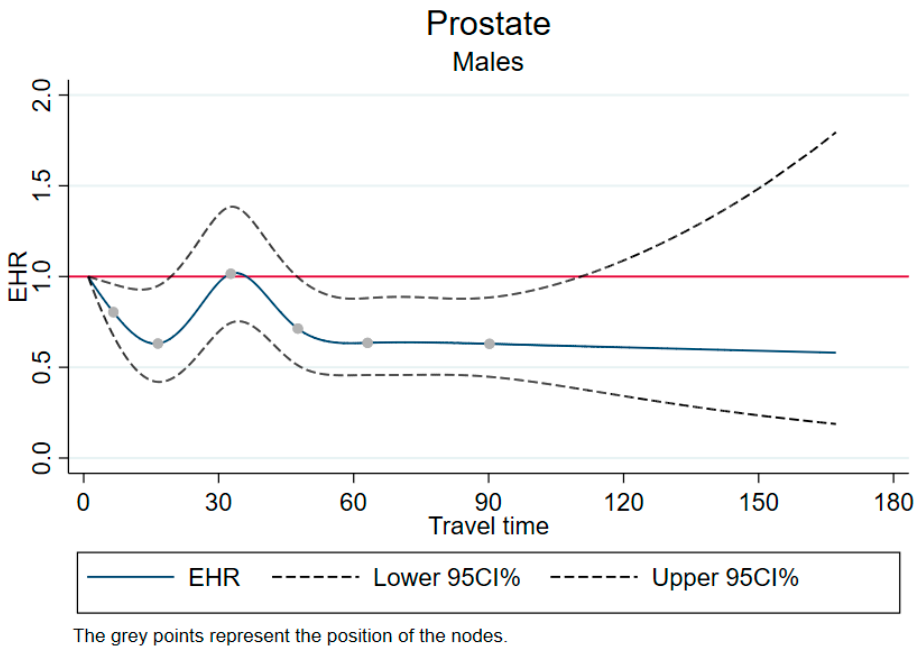
Figure 4. Excess mortality rates as a function of travel time, using restricted cubic splines—cases with better prognosis for remote patients. EHR: excess hazard ratio; CI: confidence Interval; travel time: travel time in minutes. Adjusted for year of diagnosis, age, and European Deprivation